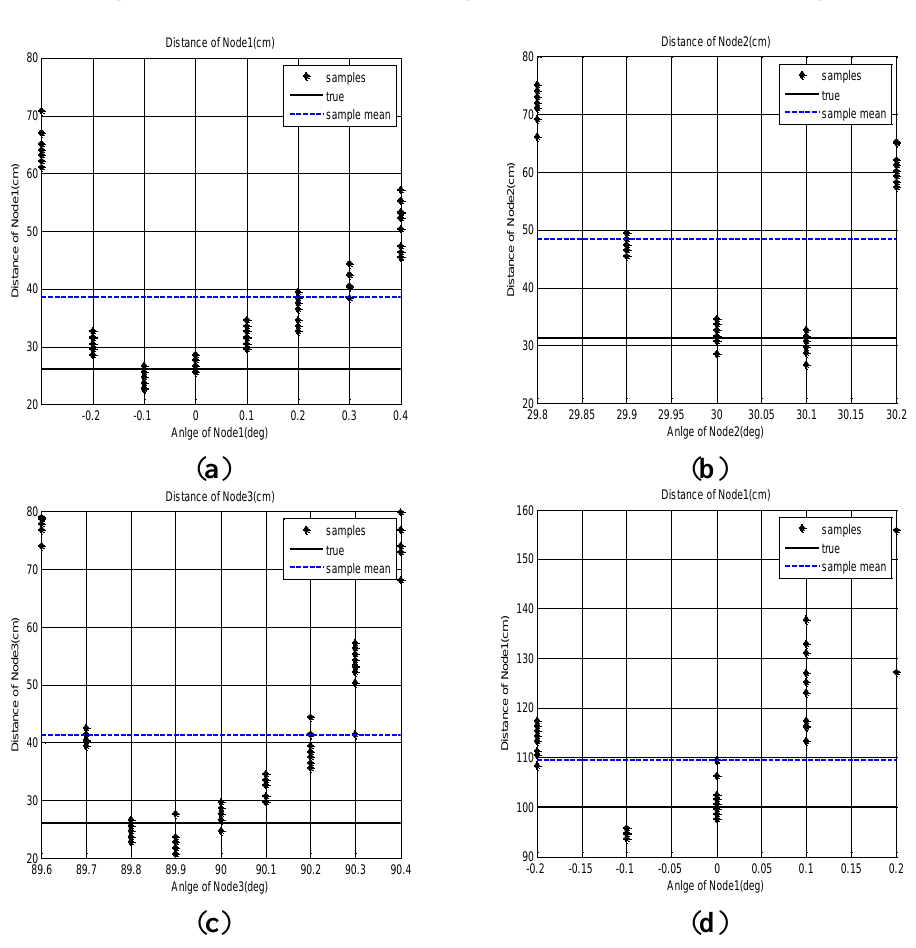
Figure 8. Scanning result with 0.1 deg resolution. ( a ) Node 1: (26 cm, 0 deg), ( b ) Node 2: (31.17 cm, 30 deg), ( c ) Node 3: (26 cm, 90 deg), ( d ) Node 1: (100 cm, 0 deg).